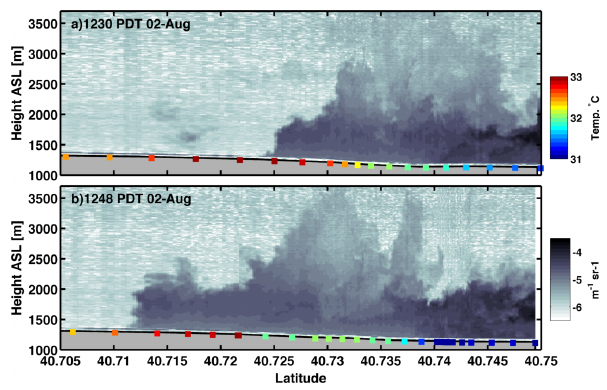
Figure 5. Lidar backscatter (m − 1 sr − 1 ) during two successive den- sity current intercept on 2 August, 2014 in the Hat Creek valley. The colored squares show the near-surface air temperature.